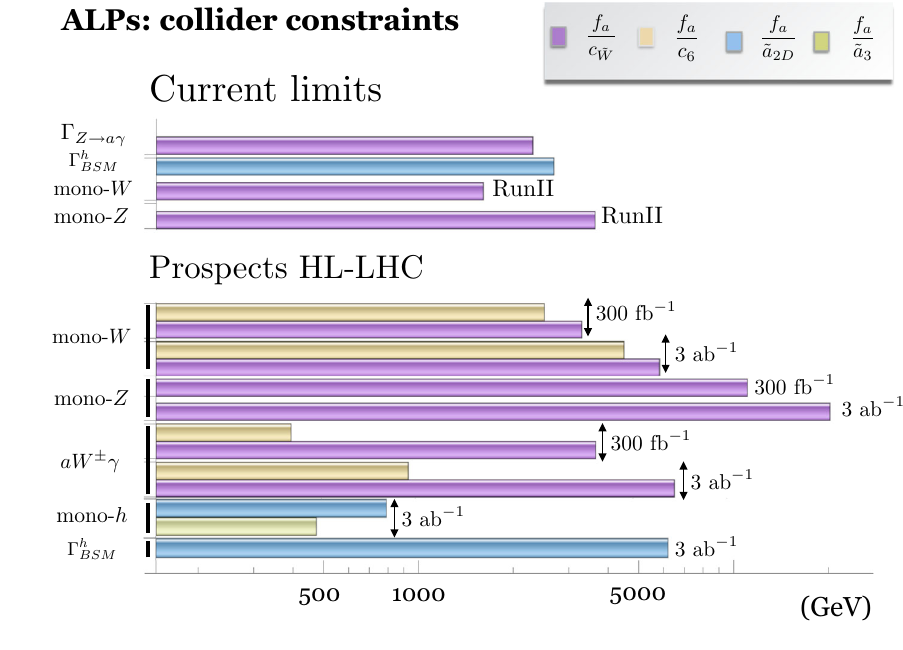
Fig. 15 Summary of the most significant constraints stemming from the studies on tree-level ALP couplings presented in this work, upon the assumption g a γγ = 0 or equivalently = − t 2 c ˜ θ c ˜ W . The upper bars B down to mono − Z prospects included correspond to 95% CL existing constraints and expected reaches, inferred in Sects. 6 and 7. The lower bars , instead, indicate the 2 (cid:2) σ projected reach of given searches at the √ s = 13TeV; see LHC with Sect. 7. Systematic uncertainties are taken into account for the present constraints but are neglected in the projected